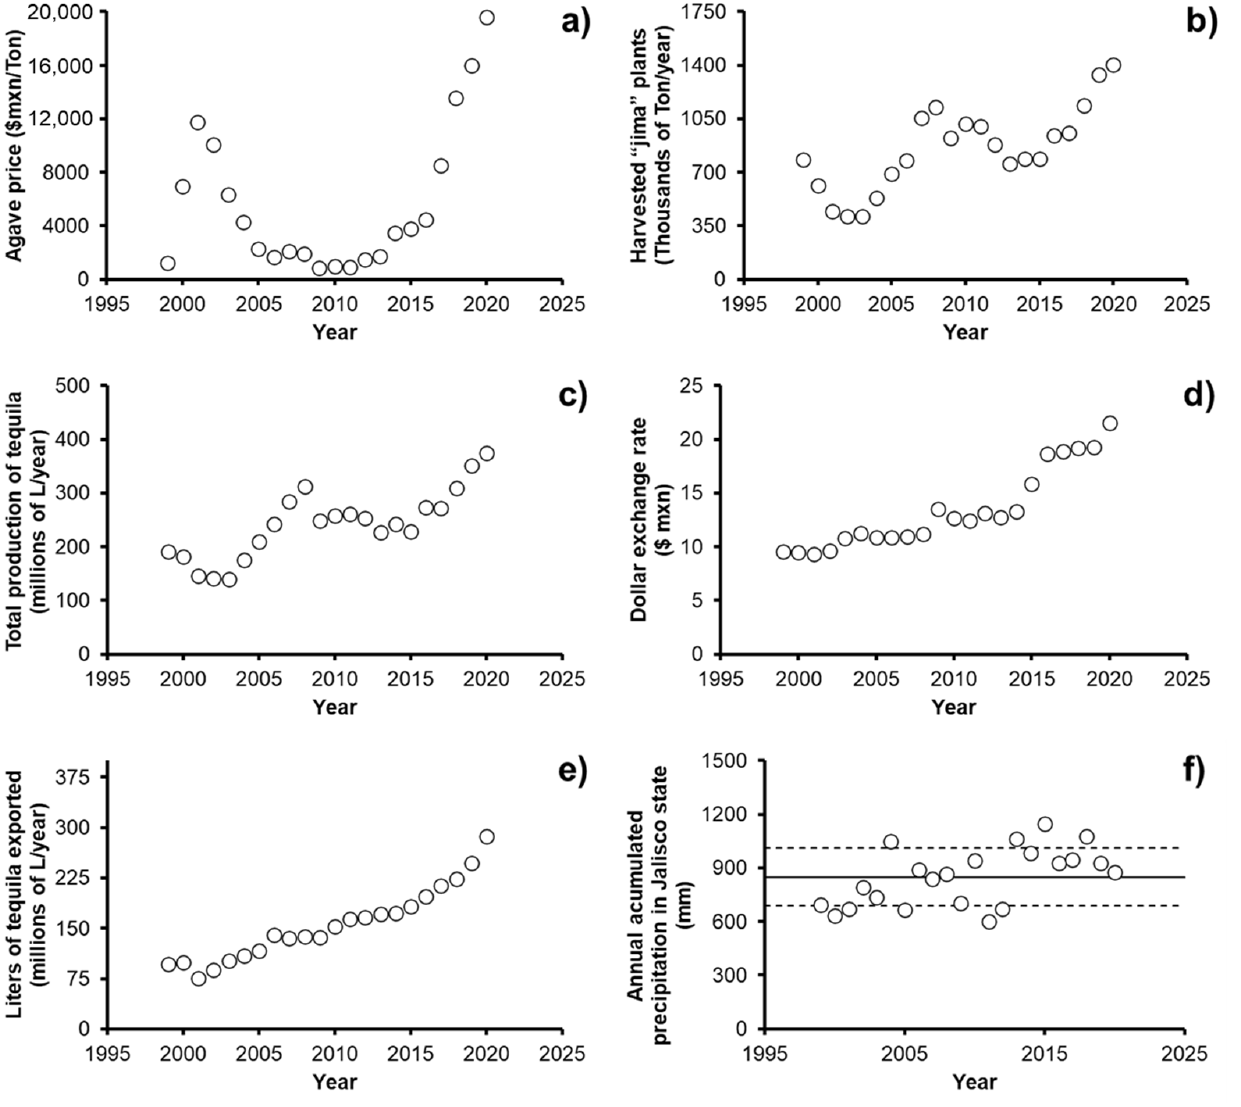
Figure 3. Historic data of: ( a ) agave price, ( b ) harvested “jima” plants, ( c ) Tequila total liters production, ( d ) dollar exchange rate, ( e ) Tequila exports, and ( f ) annual accumulated precipitation of Jalisco state, Mexico.